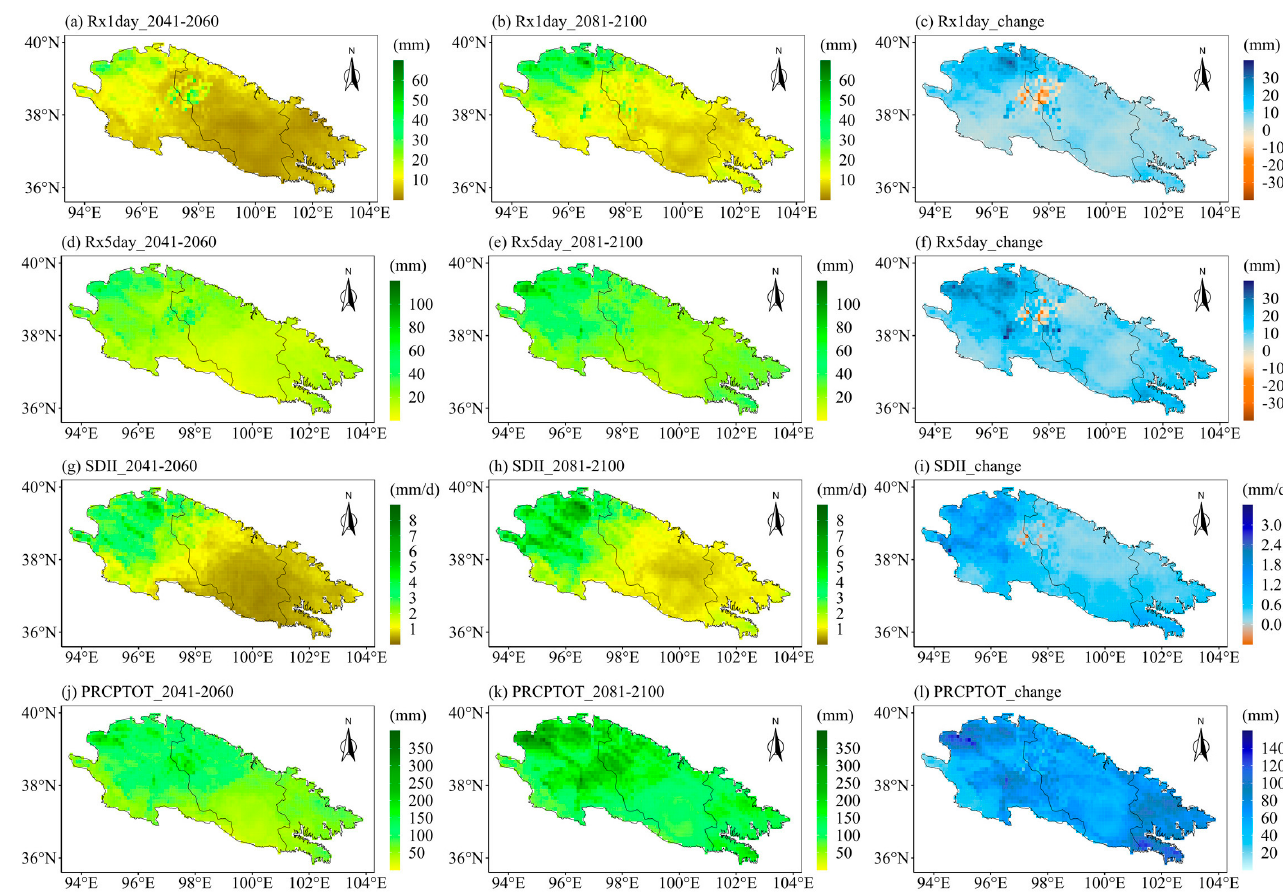
Figure 13. ( left ) The changes of extreme precipitation indices in the middle of the 21st century as compared to the base period, ( middle ) the changes of extreme precipitation indices at the end of the 21st century as compared to the base period, and ( right ) the changes of extreme precipitation indices at the end of the 21st century as compared to the middle of the 21st century. Spatial distribution over the Qilian Mountains under SSP585: (a–c) Rx1day, (d–f) Rx5day, (g–i) SDII, and (j–l) PRCPTOT. Note that the future change is represented by the ensemble of the corrected CMIP6 models.